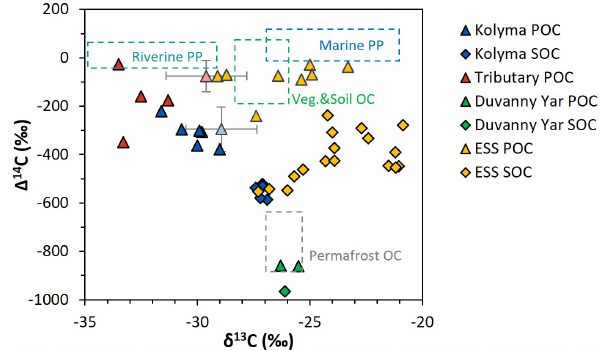
Figure 2. (cid:49) 14 C versus δ 13 C values of the Duvanny Yar (DY), Kolyma, tributary, and East Siberian Sea (ESS) samples. Triangles are POC samples, diamonds are SOC samples. The Kolyma main stem is in dark blue, ESS in yellow, tributaries in red, and the DY in green. The boxes represent the endmembers as defined in Sect. 2.6. The triangles with standard deviation show the mean ± standard de- viation of Kolyma particulate organic carbon (POC, faded blue) and Y3, one of the tributaries, POC (faded red) samples of Bröder et al. (2020) for